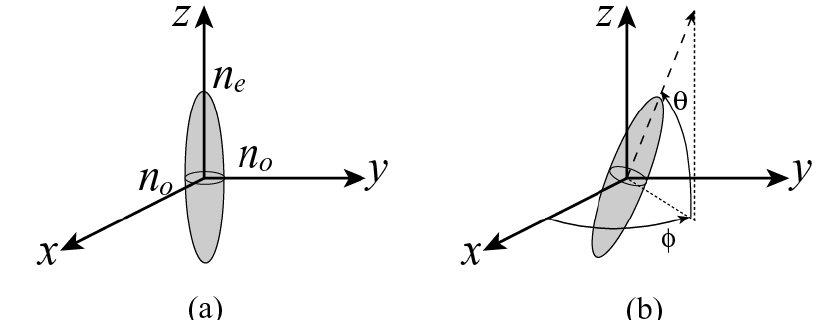
Figure 8. Uniaxial molecule in the laboratory coordinate system ( a ), and the slanted state ( b